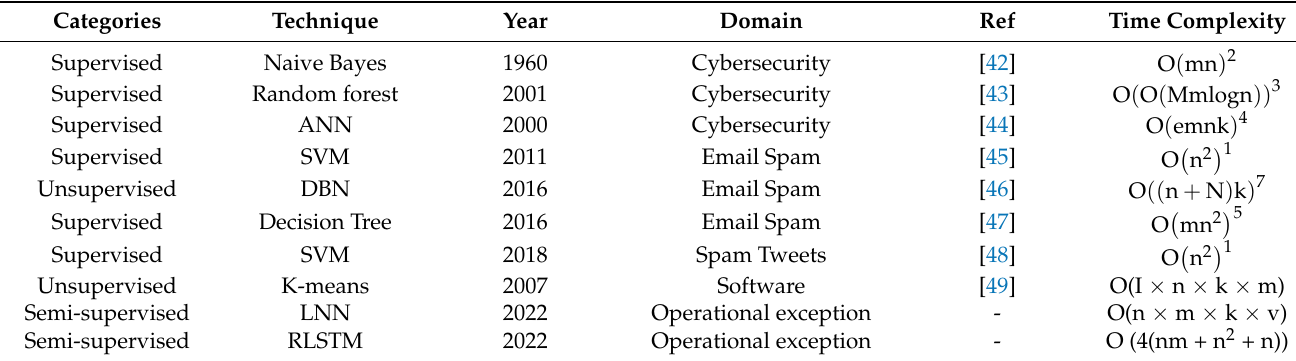
Table 3. Time complexity